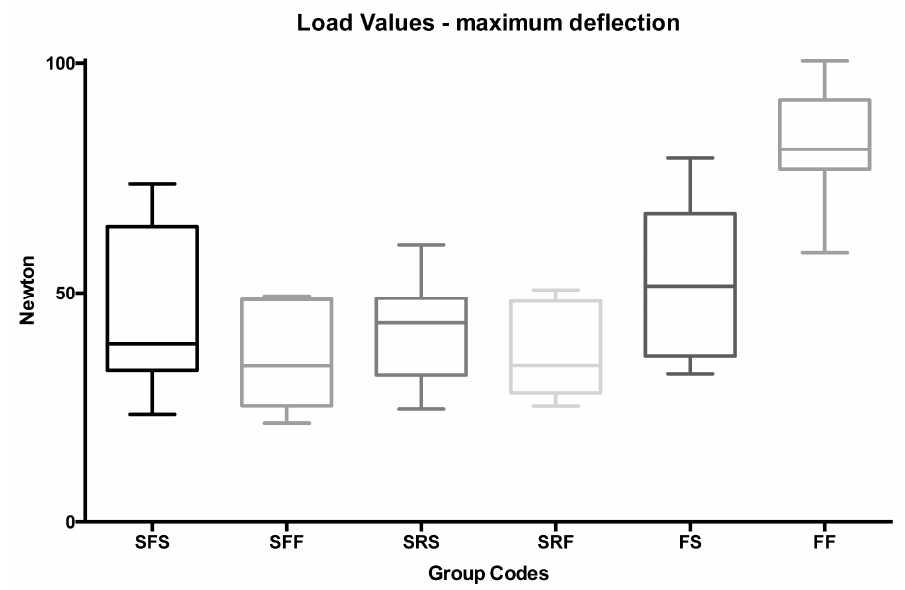
Figure 4. Box plot of load values (N) of the various groups tested at maximum deflection.